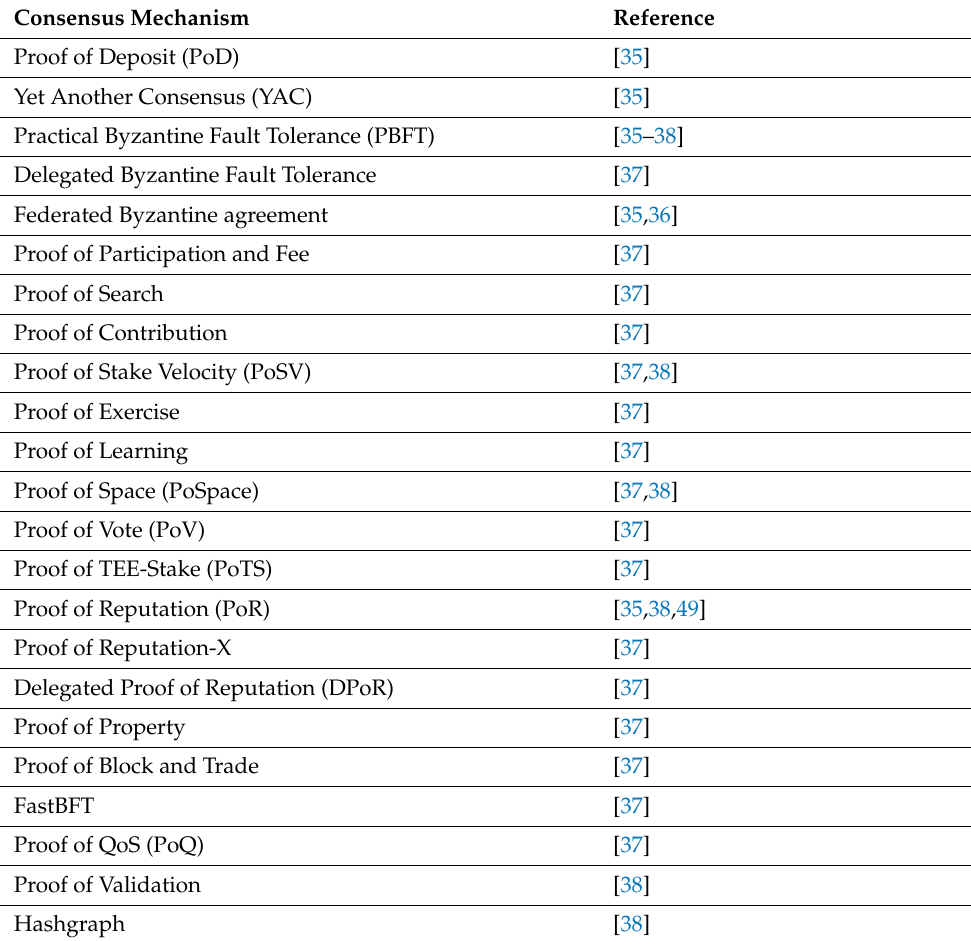
Table 1. More consensus